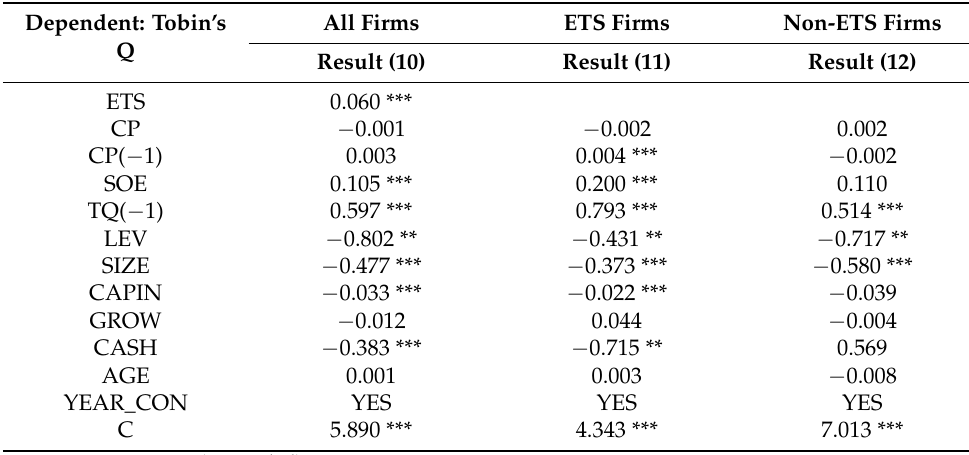
Table 11. Additional regression results: Equation